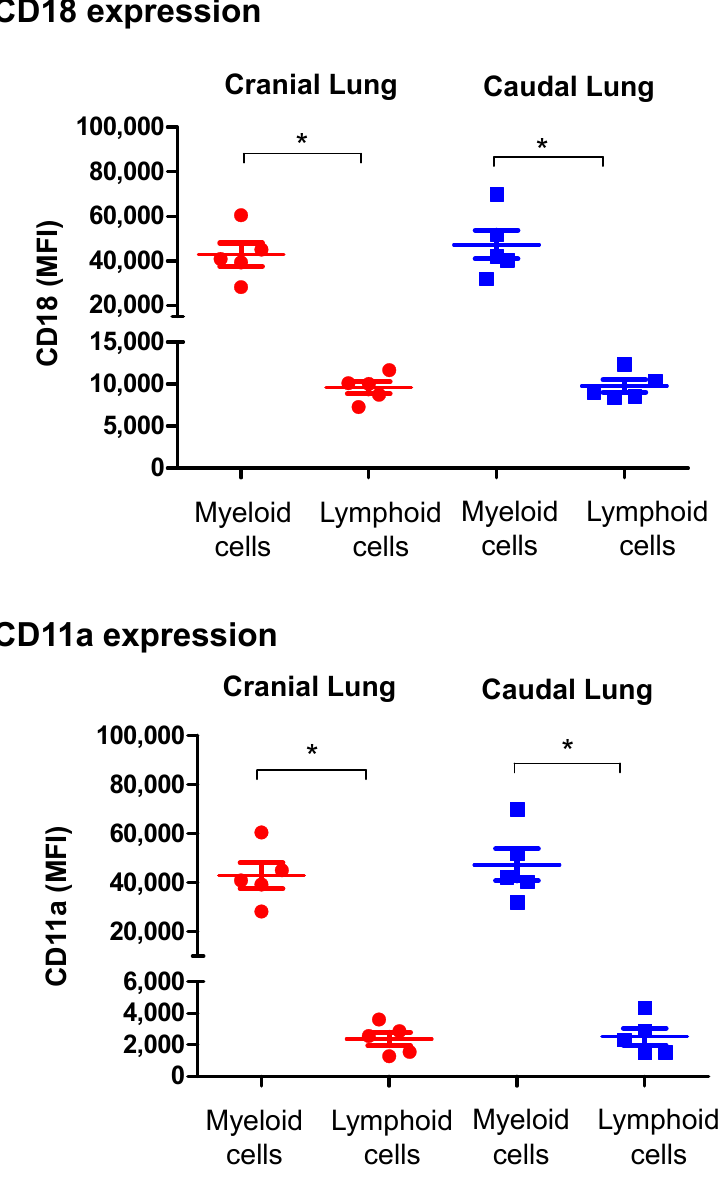
Figure 5. The expression level of the cell adhesion molecules CD18 ( A ) and CD11a ( B ) on camel lung leukocytes. Lung cells were labeled with anti-CD18-FITC and anti-CD11a-PE antibodies and analyzed by flow cytometry. CD18 and CD11a abundance was measured as the mean fluorescence intensity (MFI) of each molecule, and data were presented graphically for myeloid (SSC high ) and lymphoid (SSC low ) cells of cranial and caudal lung tissue. * indicates a significant difference between the two groups ( p < 0.05).